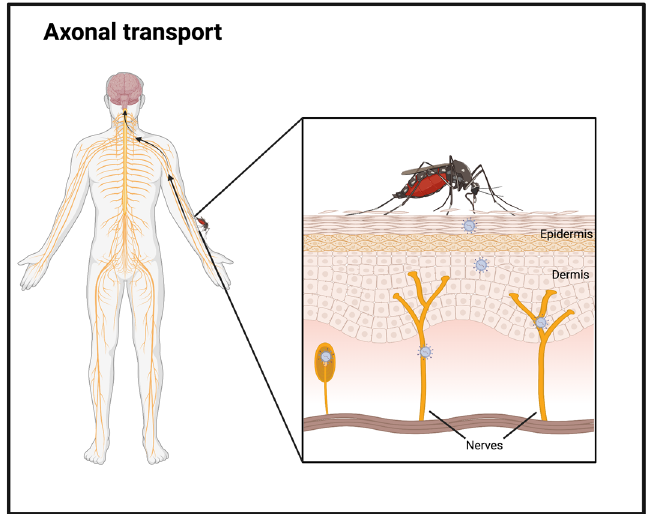
Figure 4. Flaviviruses bypassing the BBB via axonal transport. Made in